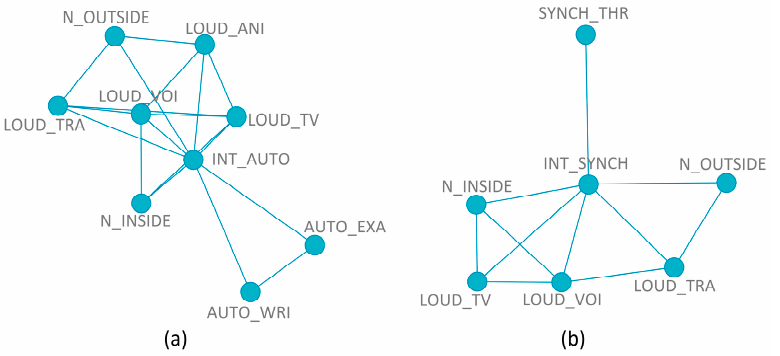
Figure 5. Inferred mRMRe network topology for the noise interference with autonomous ( a ) and synchronous ( b ) activities.